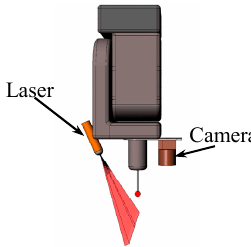
Figure 2. A visual system consisting of a laser and a camera is mounted on sides of the bodies of rotation.